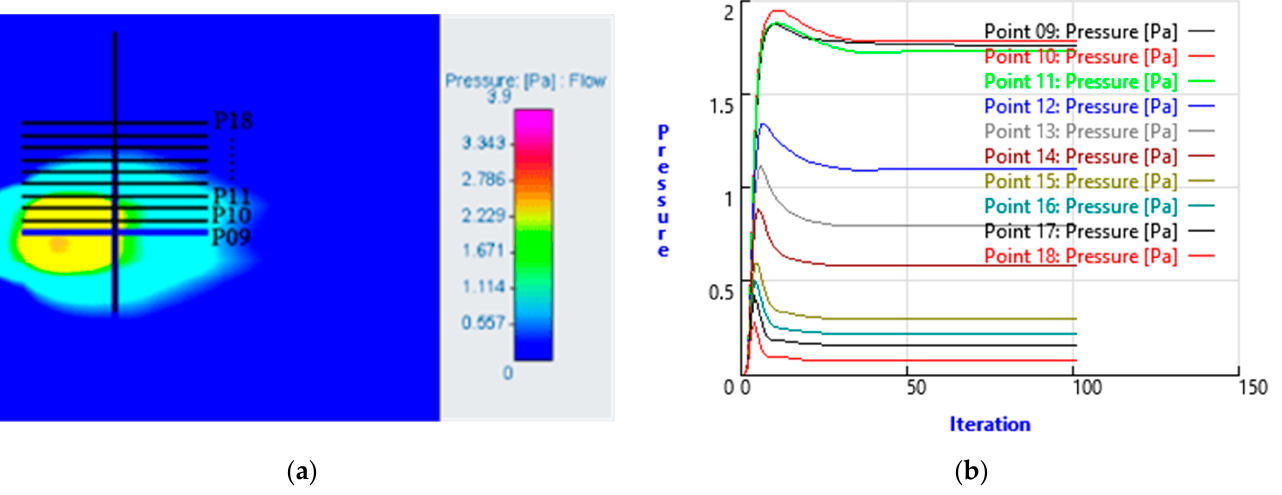
Figure 6. The first row of single pipe pressure: ( a ) distribution of monitoring points in the z-direction; ( b ) pressure distribution at each point.